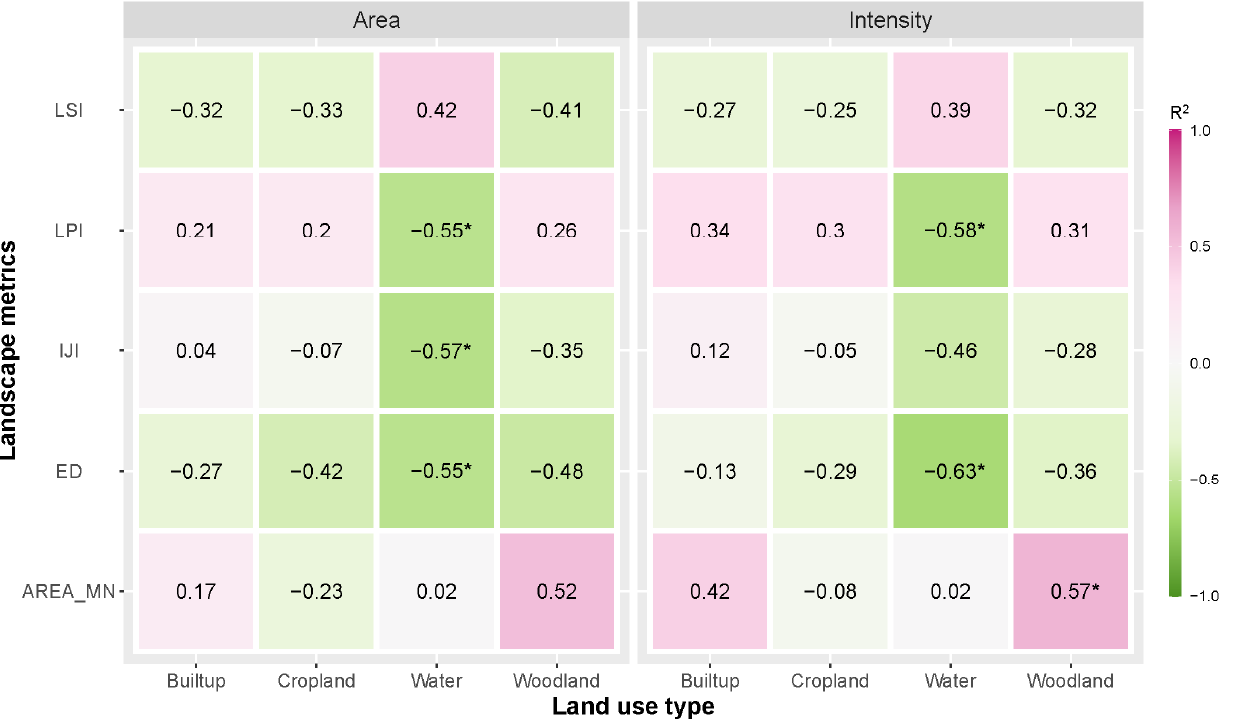
Figure 9. Correlation between the change intensity of land use and landscape patterns. Significant different (*) means p < 0.05.